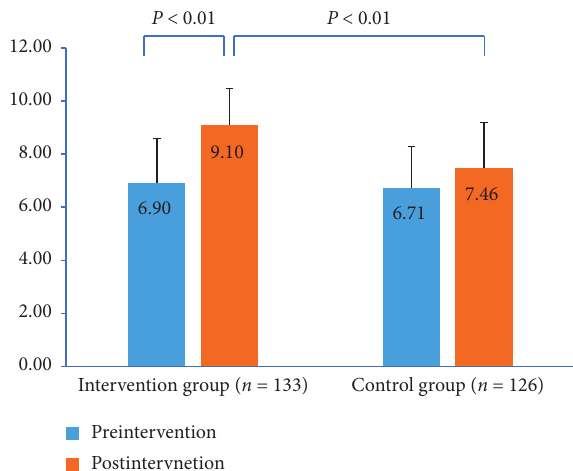
Figure 2: Inhaler technique score in the intervention group and control group pre- and Table 3: Correctness of inhaler usage score in the intervention group and control group pre- and postintervention. Time of evaluation Intervention group ( n � 133)